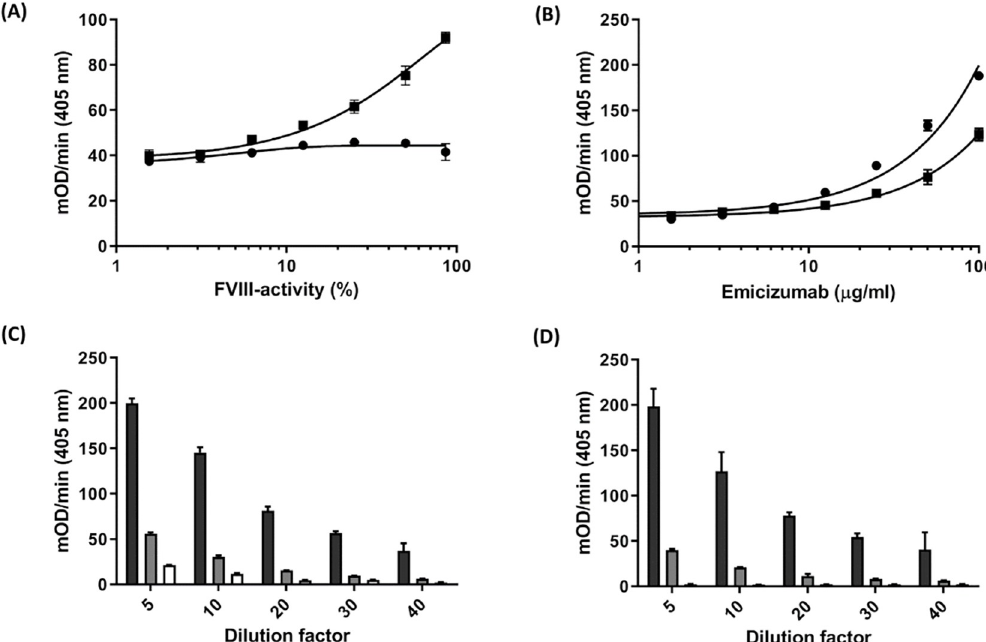
Fig 3. Pre-analytical inactivation of endogenous factor VIII and minimizing the impact of plasma matrix on determination of emicizumab plasma levels. (A) FVIII-deficient plasma was mixed with standard plasma to reach various activity levels of FVIII and then spiked with emicizumab (10 μ g/ml) and subjected to emi-tenase assay with ( ● ) or without ( ■ ) heat inactivation at 56˚C for 40 min. Plasma samples were diluted with NaCl 0.9% and FXa generation was measured after addition of FIXa (40 nM), FX (150 nM) and, S-2765 (500 nM). (B) The impact of heat inactivation on the measurement sensitivity using emicizumab spiked FVIII-deficient plasma. FVIII-deficient plasma was spiked with increasing concentrations of emicizumab and subjected to the same test system with ( ● ) and without ( ■ ) heat inactivation. To find out the optimum plasma dilution, citrated FVIII-deficient plasma (C) or NaCl 0.9% containing 0.1% BSA (D) were spiked with emicizumab (100 μ g/ml, black bars; 10 μ g/ml, grey bars and without emicizumab, white bars) and were heat inactivated. Samples were diluted with NaCl 0.9% to reach different dilution factors and incubated with FIXa (40 nM) and FX (150 nM) for 5 min. FXa generation was measured subsequent to addition of S-2765 chromogenic substrate (500 μ M). In all experiments, substrate conversion was measured at 405 nm using microtiter plate reader. Data were collected in triplicate in a kinetic measurement of 5 min and expressed as the means ±